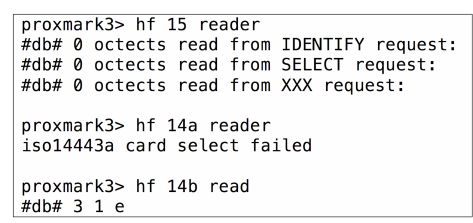
Figure 11. Determining the RFID standard of an HF tag.